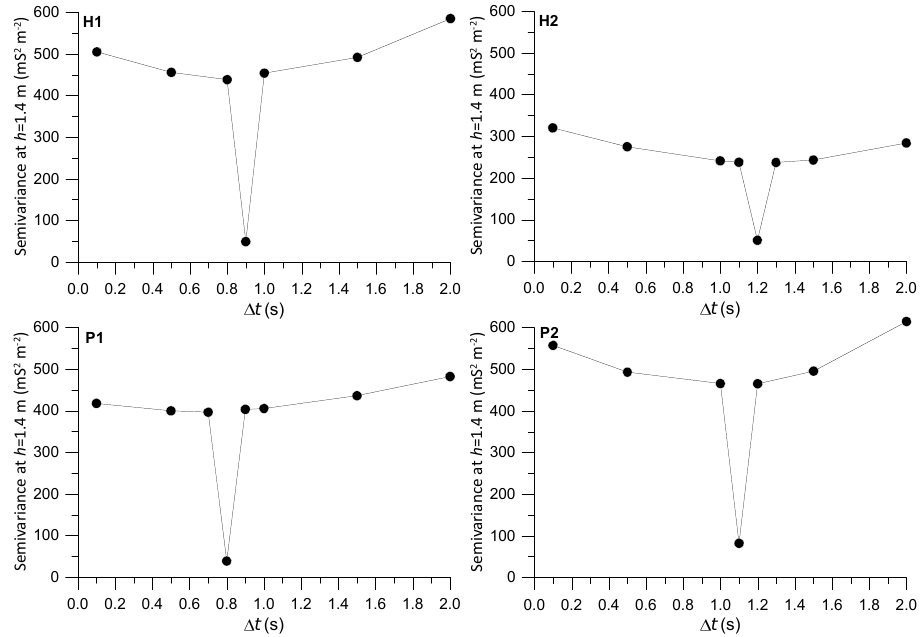
Figure 7. Semivariance at the first lag distance ( h = 1.4 m) for different Δ t and ECa signals (H1, H2, P1 and P2) using data set A + B + C.